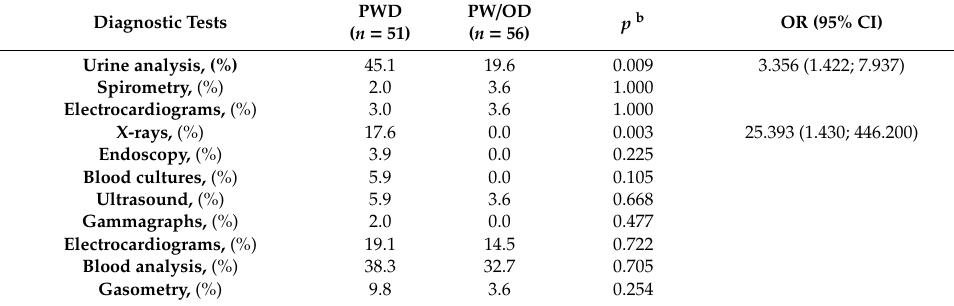
Table 5. Comparison of diagnostic tests in patients of NH with dementia (PWD) and without dementia (PW /